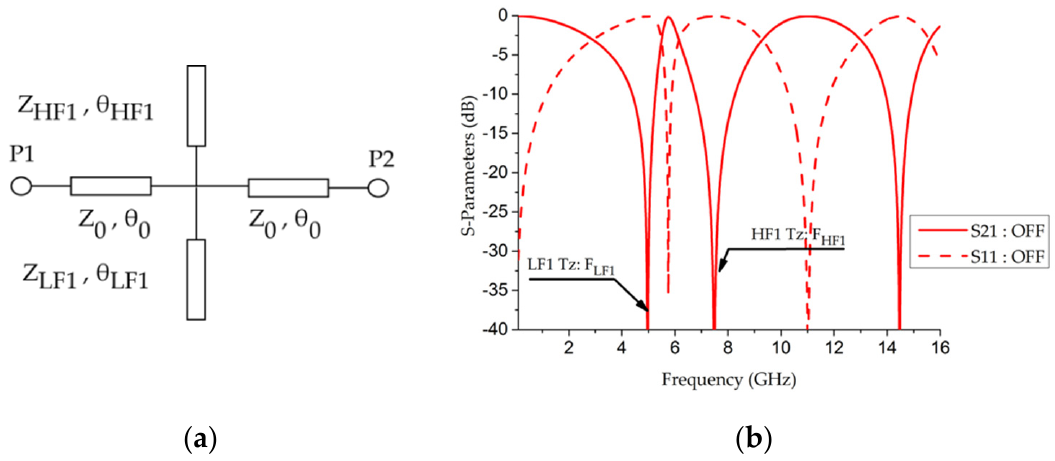
Figure 1. ( a ) Dual behavior resonator (DBR) design in the OFF state with two open-ended stubs linked to the two frequencies LF 1 and HF 1 ; ( b ) example of simulated results with the two transmission zeroes for a central frequency of 5.6 GHz.